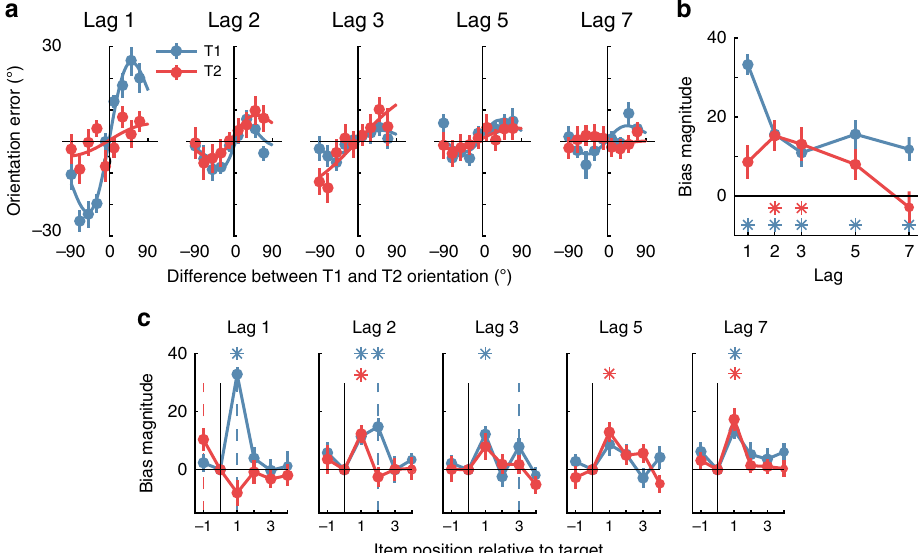
Fig. 3 The in fl uence of targets and distractors on the reported orientation in Experiment 1. a Orientation error (the difference between presented and reported orientation) plotted against the difference between T1 (blue lines) and T2 (red lines) orientations (divided into 30° bins, for clarity of presentation). Positive values on the X -axis indicate that a given target was rotated clockwise relative to the other target. For instance, when examining T1, a positive value indicates that T2 was rotated clockwise relative to T1, whereas a negative value indicates that T2 was rotated anti-clockwise relative to T1. For T1, the plotted values re fl ect the calculation of T1 minus T2, and vice versa for the calculation of T2, to ensure values were equivalent for the comparison of interest. The same convention applies to orientation error, shown on the Y -axis. The fi tted line is the fi rst derivative of a Gaussian (D1) function showing the orientation-tuned gain and width of the response. b Bias magnitude was quanti fi ed across participants by fi tting the D1 function to each participant ’ s (non-binned) data, with the gain showing bias magnitude. A positive gain on the Y -axis indicates that the perceived orientation was biased toward, rather than away from, the other target. c Bias magnitude by difference with target and distractors. For both T1 and T2, the difference between the target and the item was found in the same manner as in ( a ). We fi t the D1 function to fi nd the magnitude of bias induced by each item for each participant. The dotted coloured lines indicate the temporal position of the other target (T1 = blue, T2 = red). For all panels, the asterisks indicate, for each target (colour matched), at which lags the bias was signi fi cantly greater than zero (Bonferroni-corrected one-sample t -tests p < 0.05). Across all panels, error bars indicate ∓ 1 standard error of